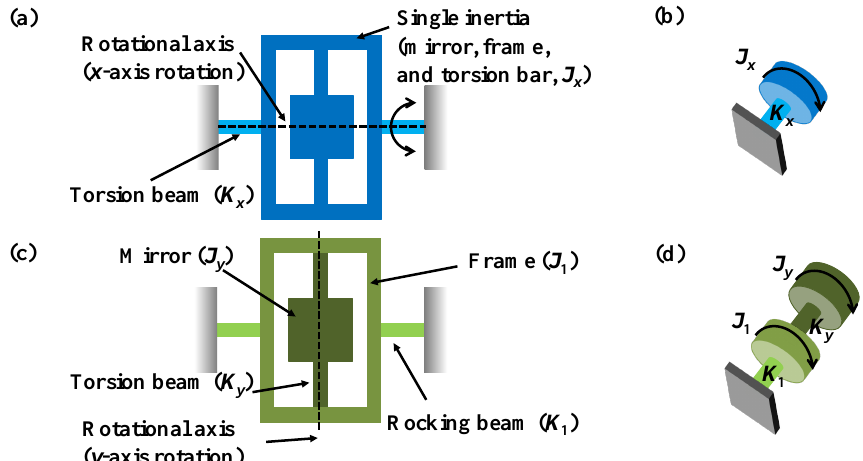
Figure 5. Mechanical model of MEMS scanner for fast and slow scanning modes: ( a ) Schematic diagram of the scanner for slow scanning mode, ( b ) rotation spring-mass-damping model for slow scanning mode, ( c ) schematic diagram of the scanner for fast scanning mode, ( d ) rotation spring- mass-damping model for fast scanning